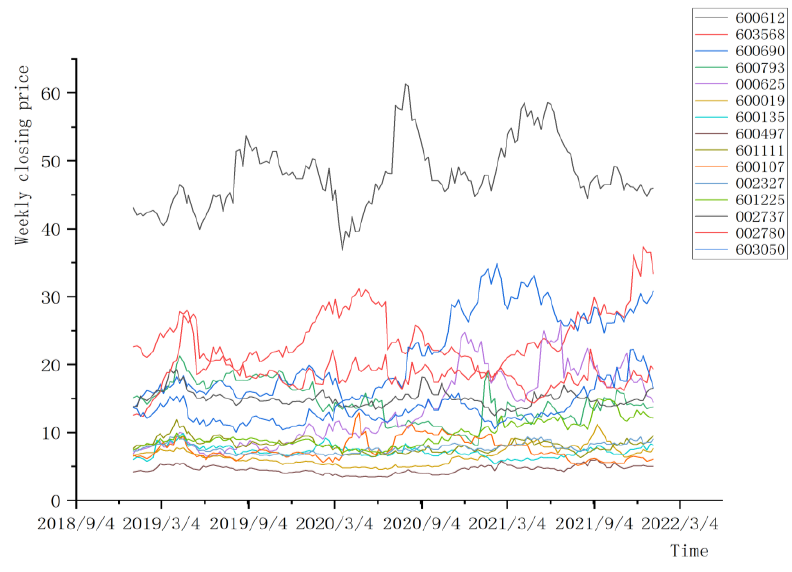
Figure 4. The weekly closing price trend for the 15 stocks data.